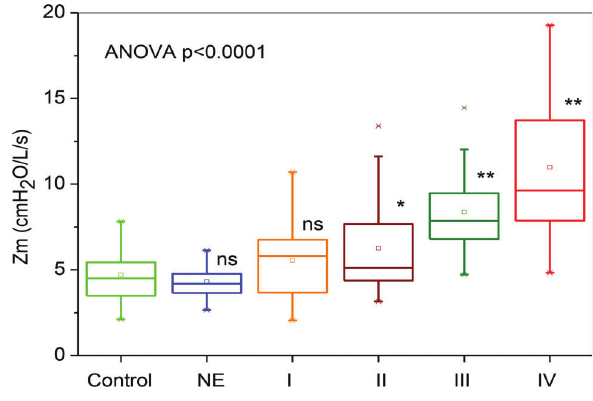
Figure 1 - Respiratory impedance values throughout the respiratory cycle in healthy subjects; in smokers with normal spirometry; and in chronic obstructive pulmonary disease patients with mild (I), moderate (II), severe (III) or very severe (IV) airway obstruction. The top and bottom of the box plots represent the 25th- and 75th-percentile values, respectively. Additionally, the circles represent the mean values, the bars across the boxes represent the median values, and the whiskers outside the boxes represent the 5th- and 95th-percentile values. Differences relative to the controls: * p o 0.01; ** p o 0.0001.